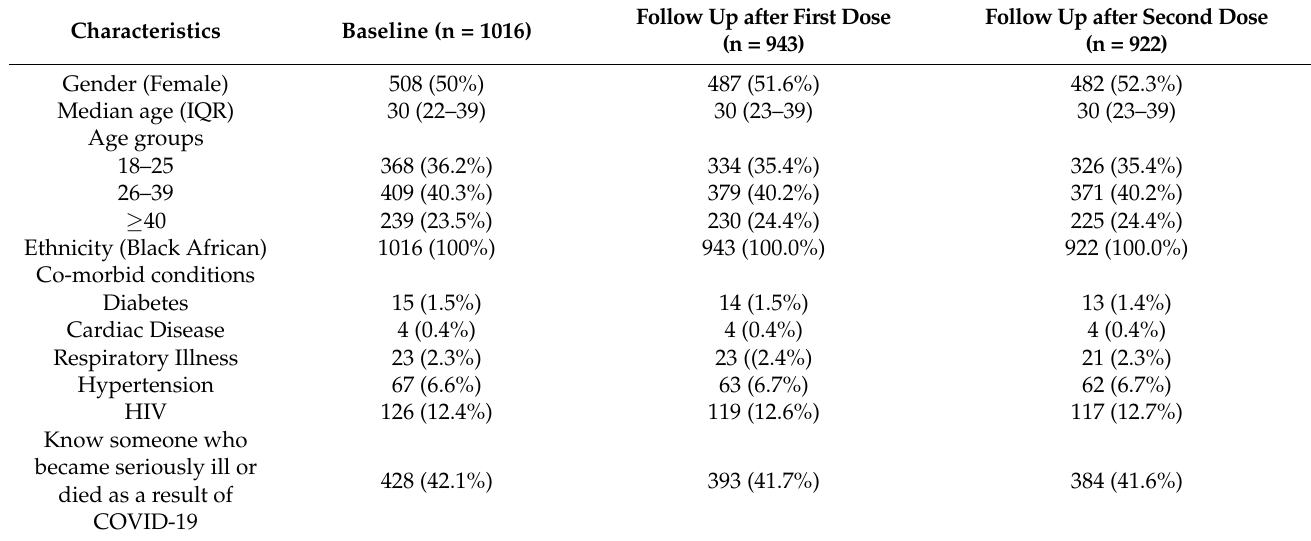
Table 2. Baseline characteristics of the study